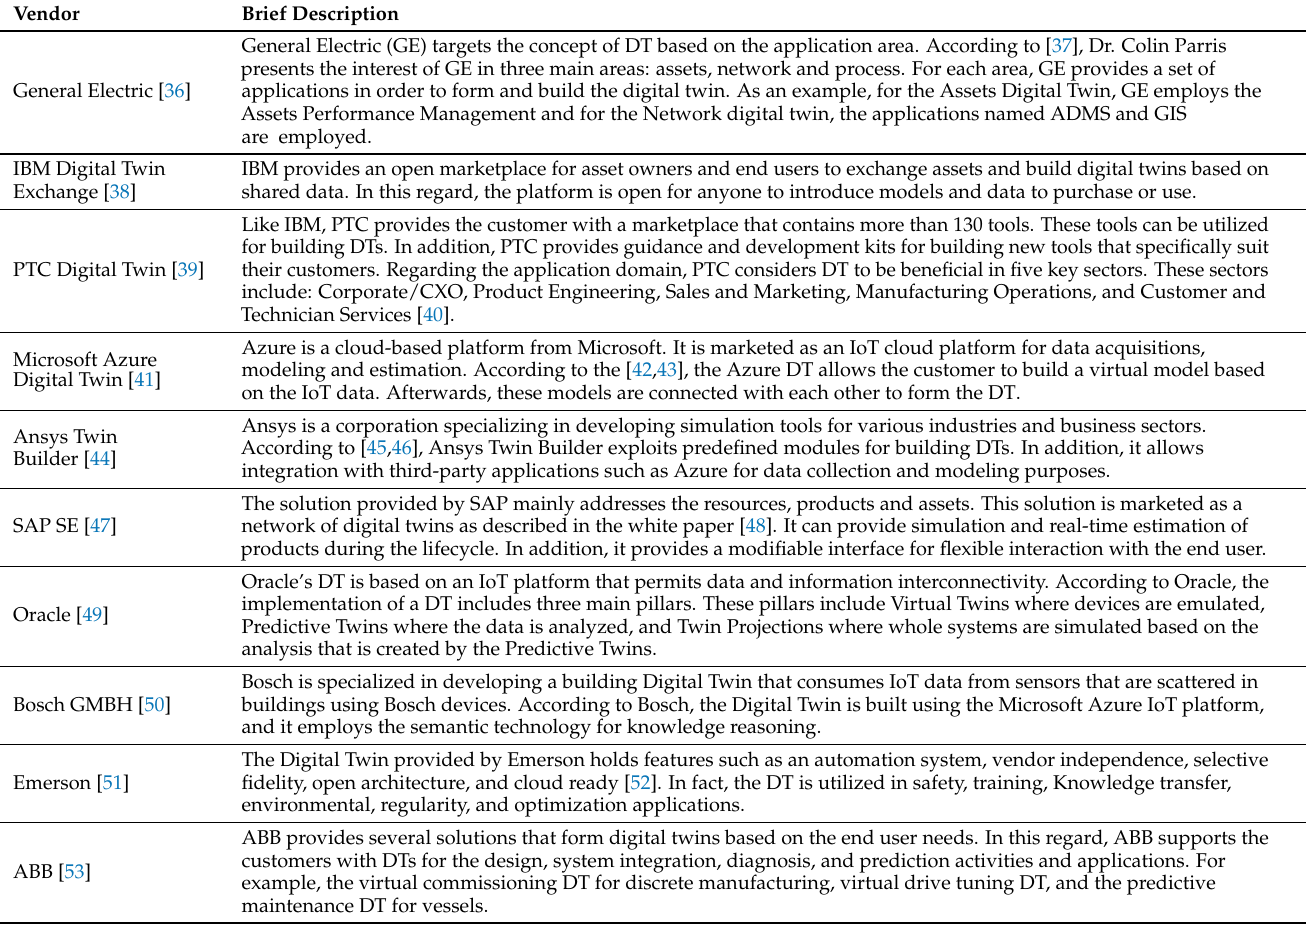
Table 1. Commercially available solutions for building